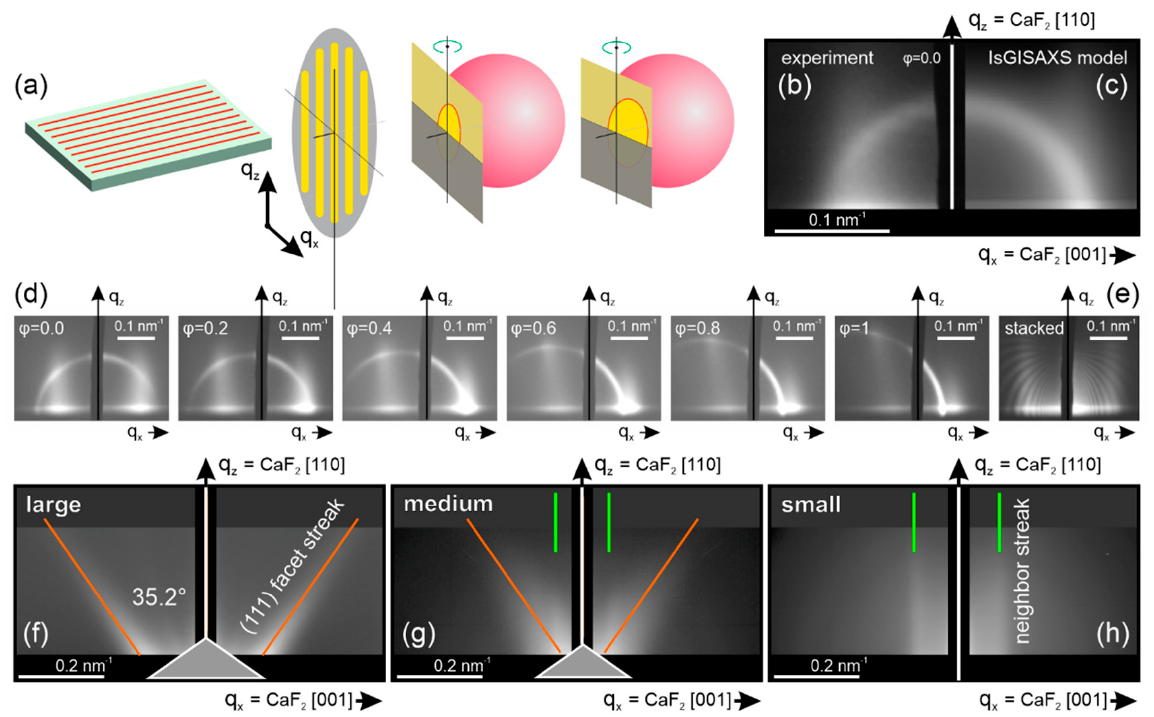
Figure 2. The reciprocal space structure corresponding to a set of parallel stripes is a flat modulated disk, whereas the arc in grazing-incidence small-angle X-ray scattering (GISAXS) results from the intersection of this disk with the Ewald sphere ( a ). The shape and position of the arc are sharply dependent on the X-ray beam azimuth with respect to the ridges ( d ). The arc+stripes GISAXS shape is confirmed by comparing experimental GISAXS pattern ( b ) with the IsGISAXS model ( c ). To reconstruct the full reciprocal space structure, one has to stack together multiple GISAXS images obtained upon sample rotation ( e ). GISAXS stacked maps obtained for CaF 2 stripes of large ( f ), medium ( g ) and small ( h ) size in the geometry where the X-ray beam travels along the ridge top. Remarkably, the inclined facet streaks become less pronounced in small ridges. On the contrary, the nearest neighbor vertical streaks become well defined in the sample with small ridges. Axis q z is perpendicular to the substrate surface, and axis q x is perpendicular to the stripes.